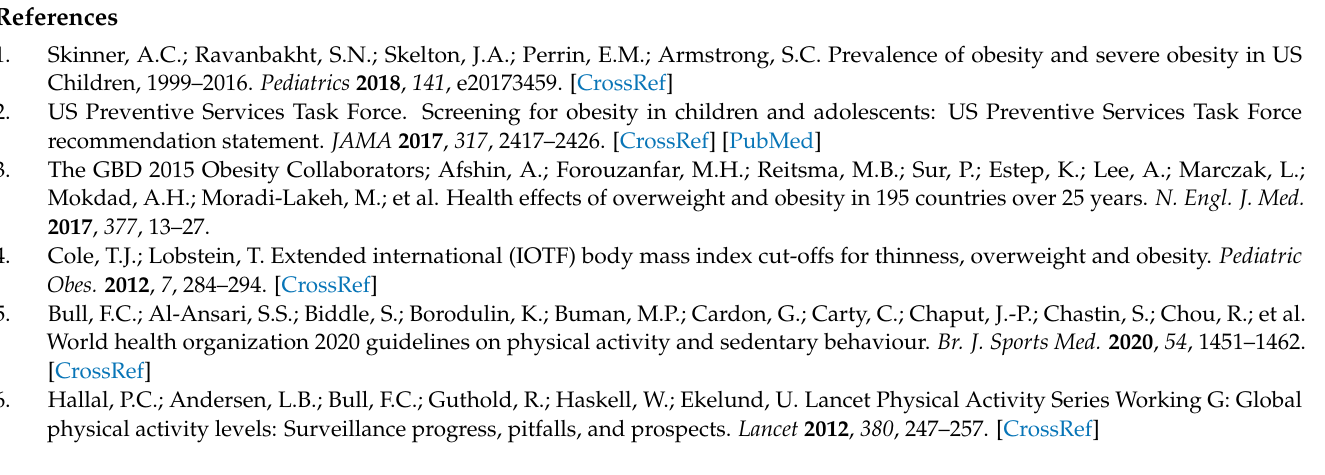
cholesterol (LDL-C)—HIIT vs. MICT metainf; Figure S16. Funnel plot of high-intensity interval training versus moderate-intensity continuous training on body mass (BM)—HIIT vs. MICT plot and metatrim results; Figure S17. Funnel plot of high-intensity interval training versus moderate-intensity continuous training on body mass index–HIIT vs. MICT plot and metatrim results; Figure S18. Funnel plot of high-intensity interval training versus moderate-intensity continuous. Funnel plot of high-intensity interval training versus moderate-intensity continuous training on fat free mass; Figure S19. Funnel plot of high-intensity interval training versus moderate-intensity continuous. Funnel plot of high-intensity interval training versus moderate-intensity continuous training on maximal oxygen uptake (VO 2max )—HIIT vs. MICT plot and metatrim results; Figure S20. Funnel plot of high-intensity interval training versus moderate-intensity continuous. Results of trim and fill method for high-intensity interval training versus moderate-intensity continuous training on systolic blood pressure (SBP)—HIIT vs. MICT plot and metatrim results; Figure S21. Funnel plot of high-intensity interval training versus moderate-intensity continuous. Results of trim and fill method for high-intensity interval training versus moderate-intensity continuous training on diastolic blood pressure (DBP); Figure S22. Funnel plot of high-intensity interval training versus moderate-intensity continuous training on triglycerides (TG)—HIIT vs. MICT plot and metatrim results; Figure S23. Funnel plot of high-intensity interval training versus moderate-intensity continuous. Funnel plot of high-intensity interval training versus moderate-intensity continuous training on high-density lipoprotein cholesterol (HDL); Figure S24. Funnel plot of high-intensity interval training versus moderate-intensity continuous training on low-density lipoprotein cholesterol (LDL)—HIIT vs. MICT plot and metatrim results.; Figure S25. Funnel plot of high-intensity interval training versus moderate- intensity continuous training on blood glucose (BG)—HIIT vs. MICT plot and metatrim results; Figure S26. Funnel plot of high-intensity interval training versus moderate-intensity continuous. Funnel plot of high-intensity interval training versus moderate-intensity continuous training on homeostasis model assessment (HOMA-IR)—HIIT vs. MICT plot and metatrim